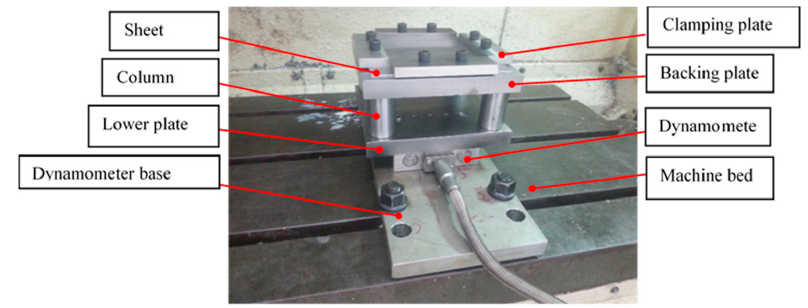
Figure 4. The forming jig with dynamometer.